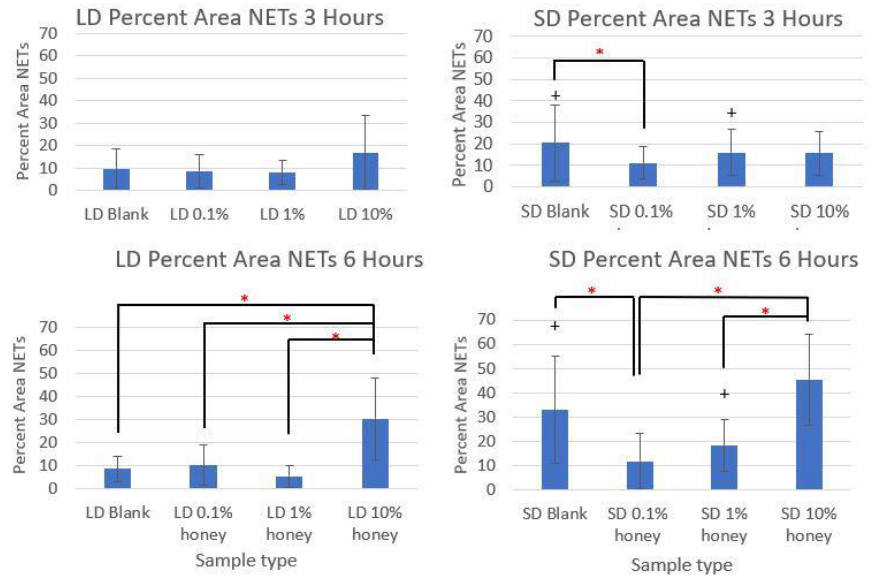
Figure 5. The incorporation of 0.1% honey significantly reduces NETosis on SD templates. percent area NETs on LD and SD templates at 3 and 6 h are shown. * indicates a significant difference between the indicated samples within that template type and timepoint, while + indicates a significant difference from the respective LD template at that timepoint and honey level. Sample size of 3 images per replicate, 4 replicates per timepoint per experiment, with 3 unique donor experiments. Raw data is available in Supplementary Spreadsheet 4. Matlab code is available in Supplementary Document 1.